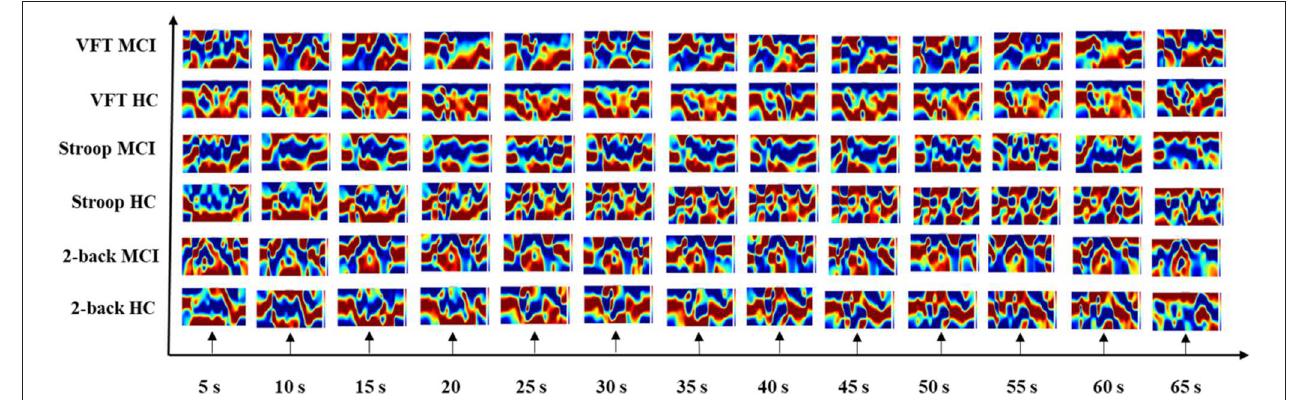
FIGURE 8 | Neuroimaging of specific time points (i.e., 5, 10, 15, 20, 25, 30, 35, 40, 45, 50, 55, 60, and 65s) in spatial domain among three mental tasks (i.e., N -back task, Stroop task, and verbal fluency task).